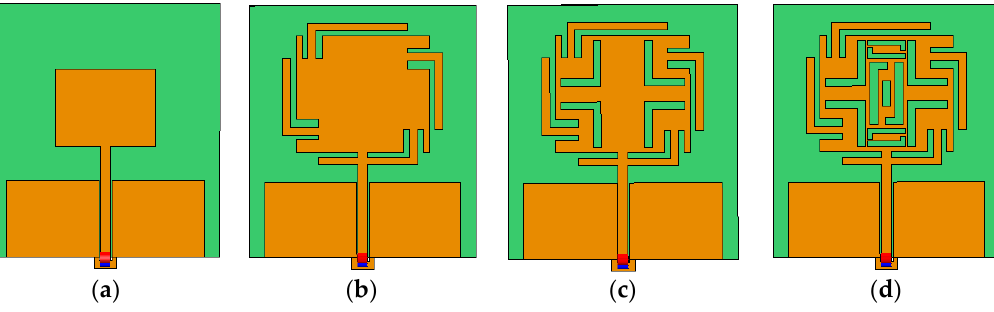
Figure 12. Dual band antenna design stages: ( a ) Step 1 ( b ) Step 2 ( c ): Step 3 ( d ) Step 4.